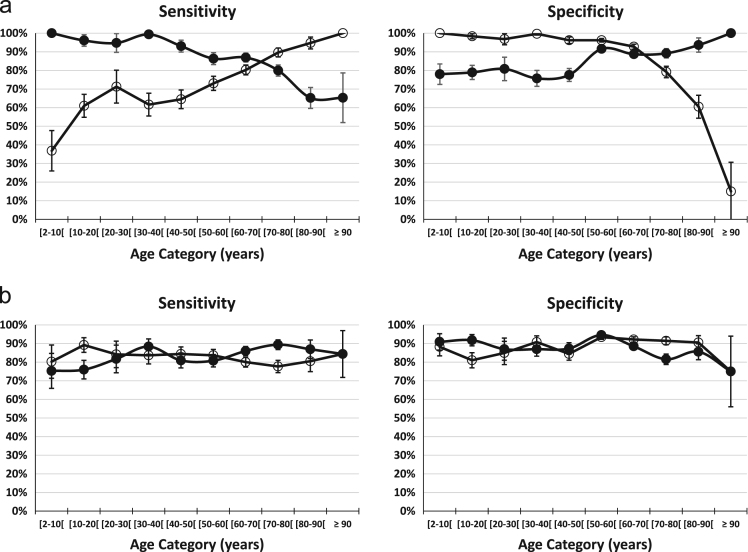
a: Sensitivity and Specificity per age-category. Solid circles correspond to Scr/Qcrea as the test result (positive when > 1.33, negative when ≤ 1.33) and diseases status defined by the fixed mGFR threshold of 60 mL/min/1.73 m². Open circles correspond to the reversed situation, that is, mGFR as the test result (positive when mGFR < 60 and negative when mGFR ≥ 60) and disease status defined by the Scr/Qcrea threshold of 1.33. b: Sensitivity and Specificity per age-category. Solid circles correspond to Scr/Qcrea as the test result (positive when > 1.33, negative when ≤ 1.33) and diseases status defined by the age-dependent mGFR threshold COAD. Open circles correspond to the reversed situation, that is, mGFR as the test result (positive when mGFR < COAD and negative when mGFR ≥ COAD) and disease status defined by the Scr/Qcrea threshold of 1.33.